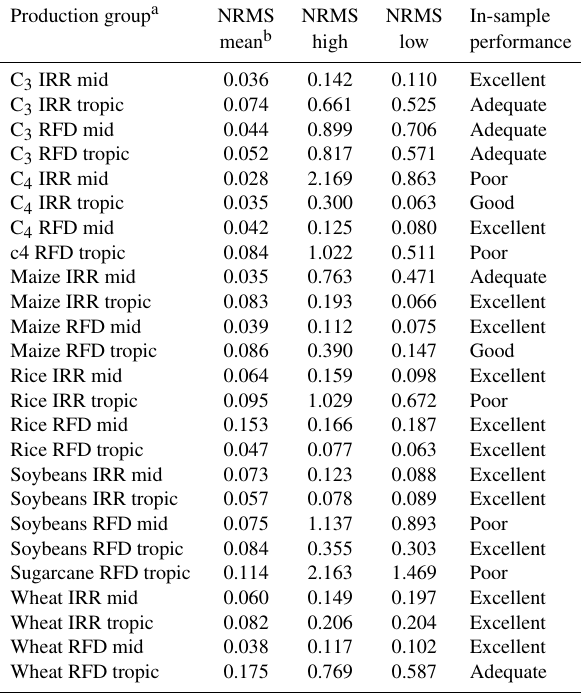
Table A1. Persephone v1.0 response function performance for all production groups, for quadratic µ CTW (Eq. A1), quadratic σ CTW (Eq. A6).